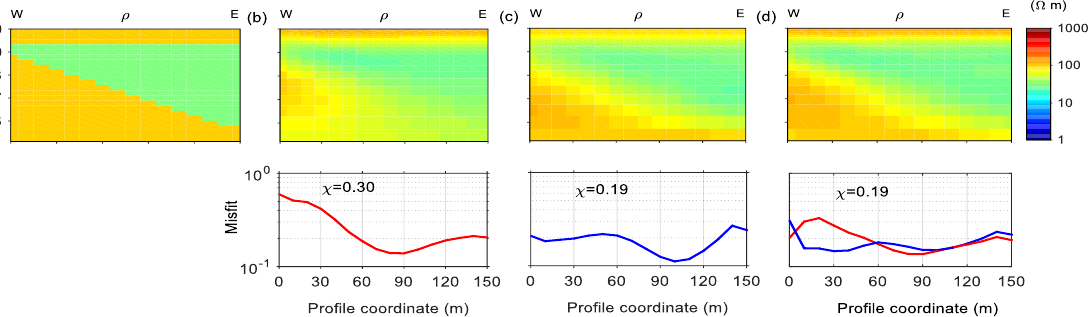
Figure 14. Comparison between the true resistivity value ( a ) and resistivity inversion results of the non-IP responses of the subtle chargeable medium: by x -data only ( b ); z -data only ( c ); and x and z data ( d ). The meanings of the curves and the area are the same as in Figure 7.